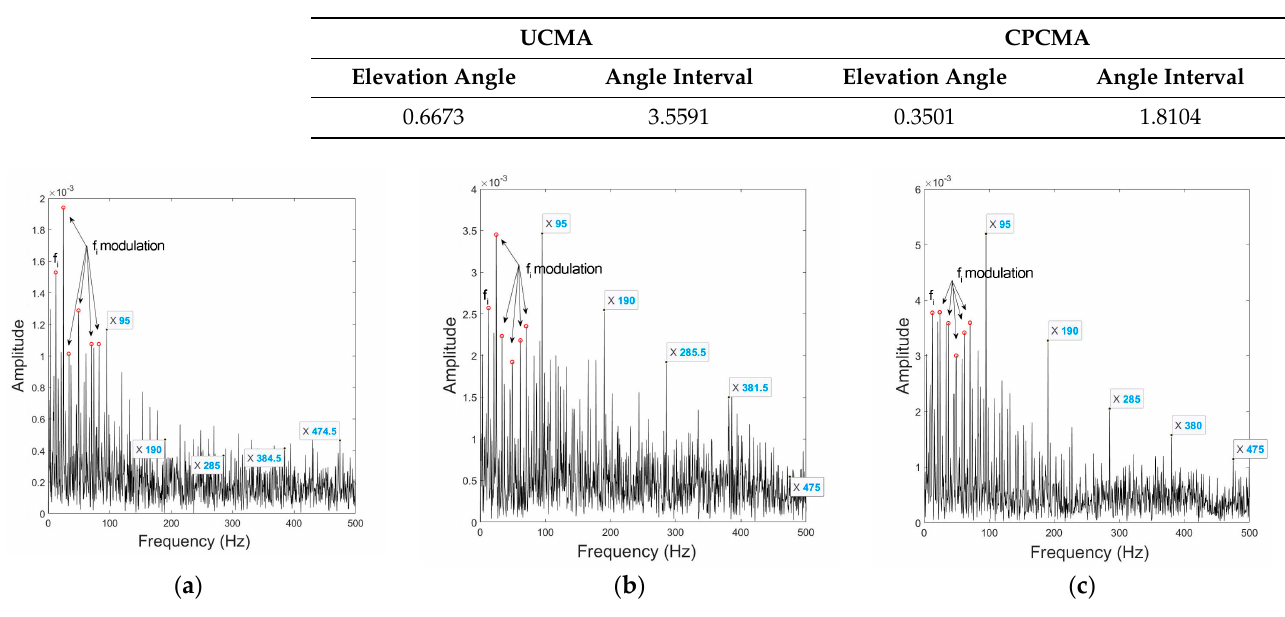
Table 20. RMSE in inner race defect located by both arrays at 725 rpm.